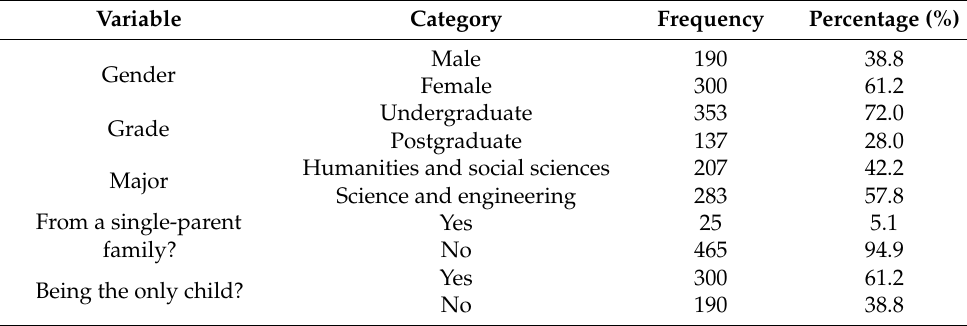
Table 1. Demographic characteristics of the final sample (n = 490).